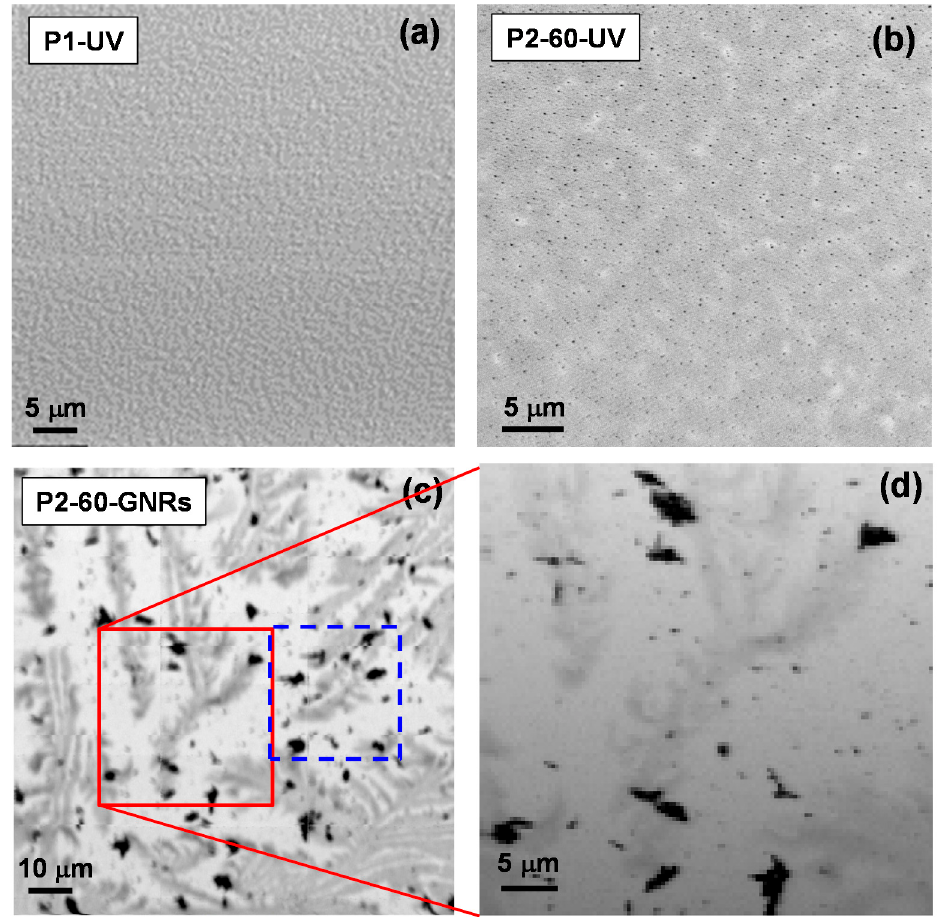
Figure 1. Scanning X-ray microscope (SXM) images for ( a ) low M w PMMA after UV irradiation; ( b ) Au–PMMA formed by UV irradiation and ( c ) gold nanorods formed by polymer immobilised seeds over Au–PMMA nanocomposite; image ( d ) is magnified image corresponding to the region assigned by red square in ( c ). The blue marked square is demonstrating a region of interest that has selected for X-ray fluorescence (XRF) mapping in Figure 3.